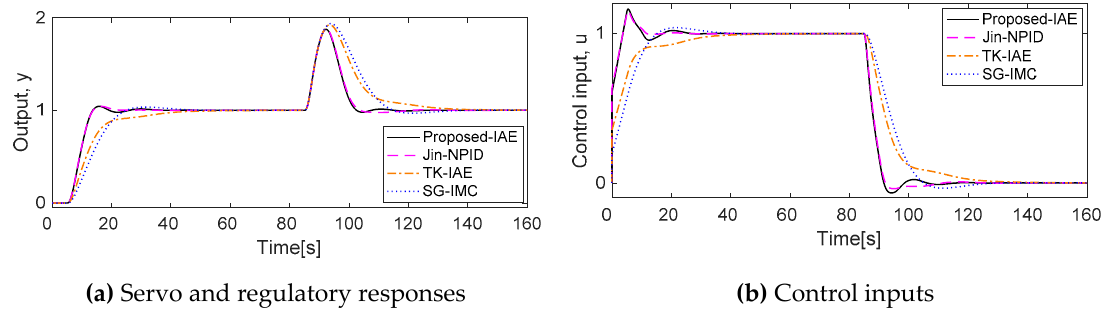
Figure 11. Servo and regulatory responses for nominal process 3. Table 8. Quantitative comparison of performances for nominal process 3.